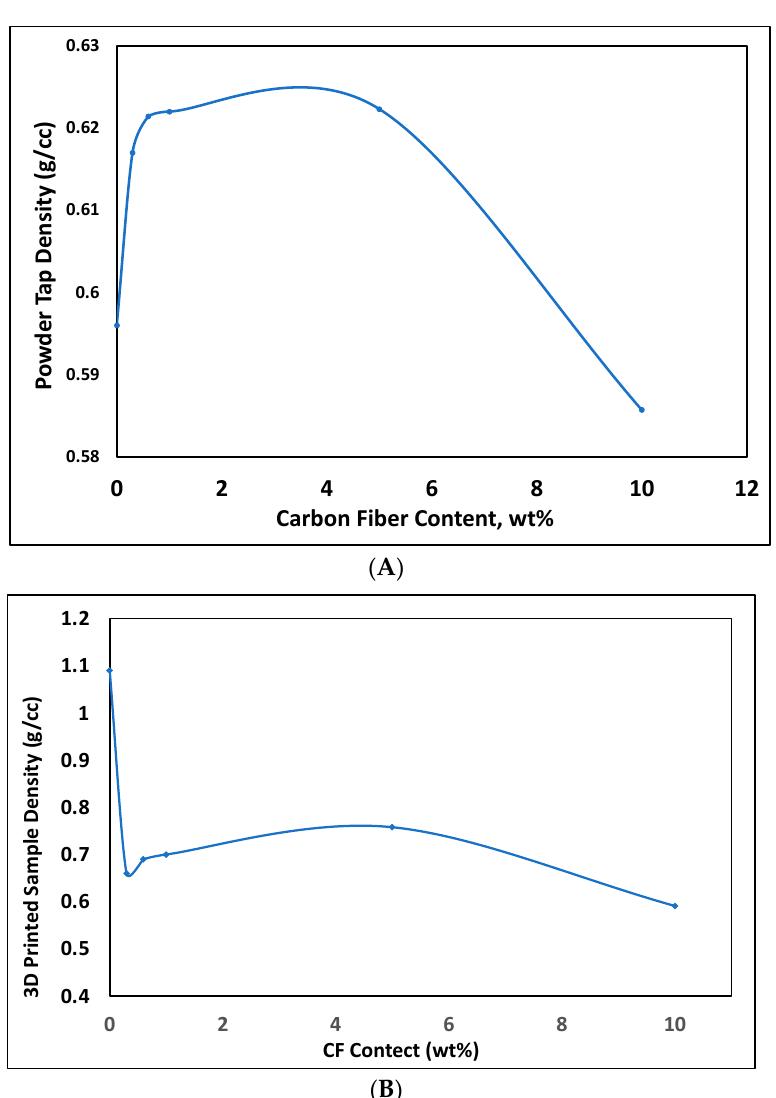
Figure 10. E ff ect of CF content in SLS-Printed fully cured thermose tt ing samples on ( A ) powder tap Figure 10. Effect of CF content in SLS-Printed fully cured thermosetting samples on ( A ) powder tap density ( B ) fully cured 3D printed sample density. density ( B ) fully cured 3D printed sample